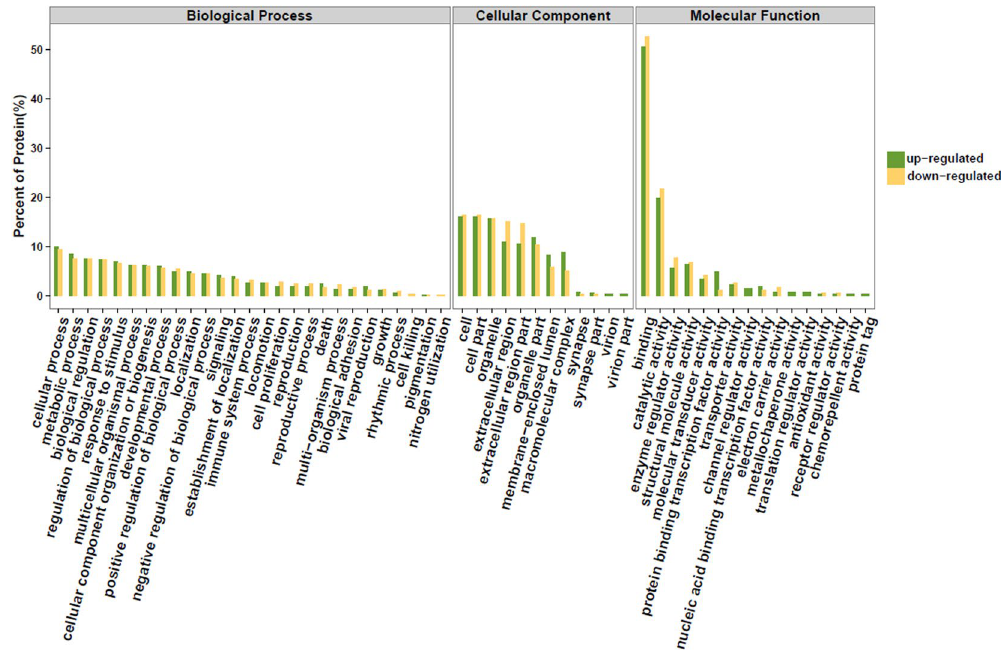
Figure 4. Gene Ontology term of up-regulated or down-regulated proteins in CM of iDFCs compared with CM of